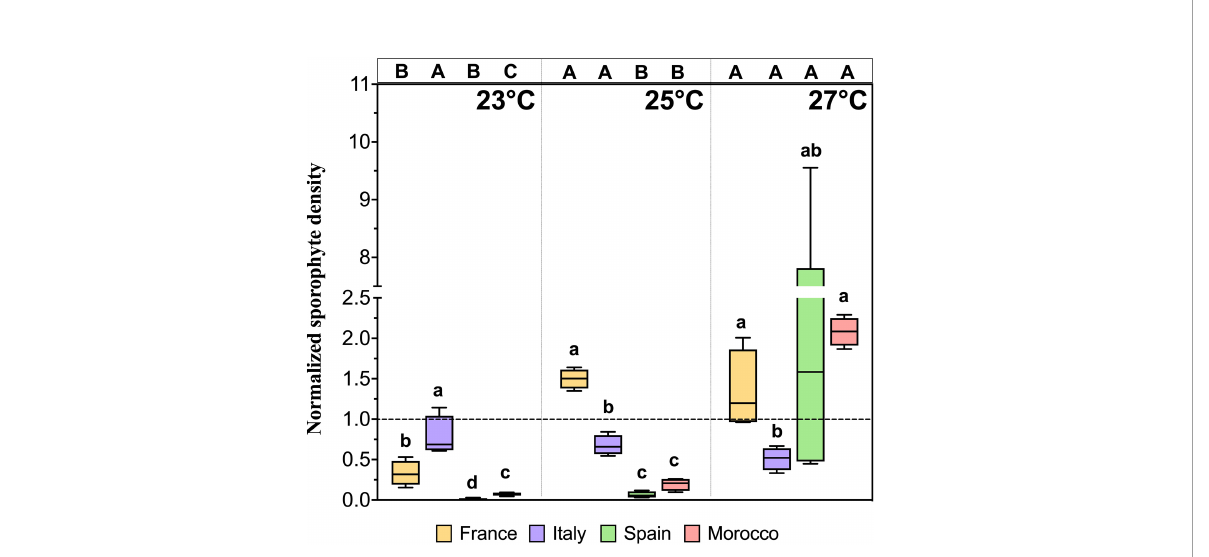
FIGURE 6 Absolute number of sporophytes per female gametophytes of different populations of Laminaria ochroleuca after recovery (day 40) from different MHW treatments. Note that the sporophyte density values were normalized to the mean control treatment value (17°C) for the respective population (dotted line). Box plots with median, boxes for 25th and 75th percentiles and whiskers indicating min and max values (n = 4). For each temperature, different lowercase letters above boxplot bars indicate signi fi cant differences between populations. For each population, different uppercase letters indicate differences between temperatures (p<0.05). See Table 5 for statistical analysis.